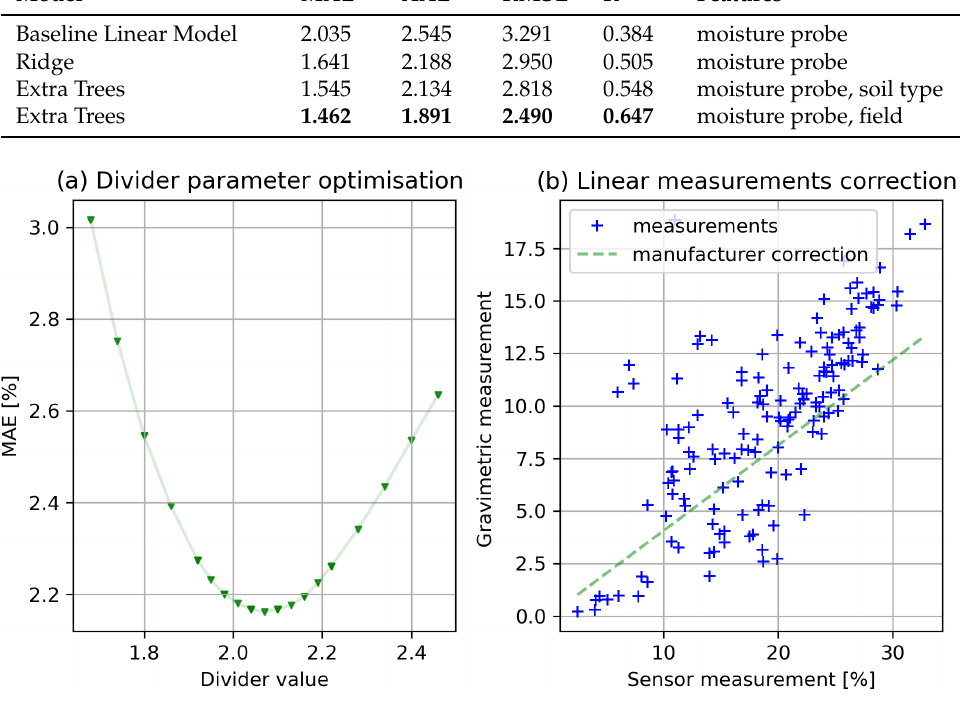
Figure 2. Initial linear model for root moisture sensor calibration; ( a ) the improvement in the model performance after the linear divider optimization; ( b ) the visualization of the resulting linear model and the reference gravimetric